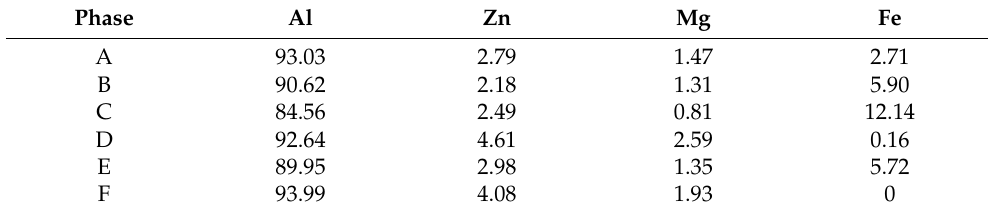
◦ C isothermal treatment: ( a ) 800 s; ( b ) 1500 s. Figure 3. SEM images of the samples quenched at 295 °C isothermal treatment:( a ) 800 s; ( b ) 1500 s. Figure 3. SEM images of the samples quenched at 295 Table 2. The chemical composition of second phases in DA and 295 ◦ C isothermal samples